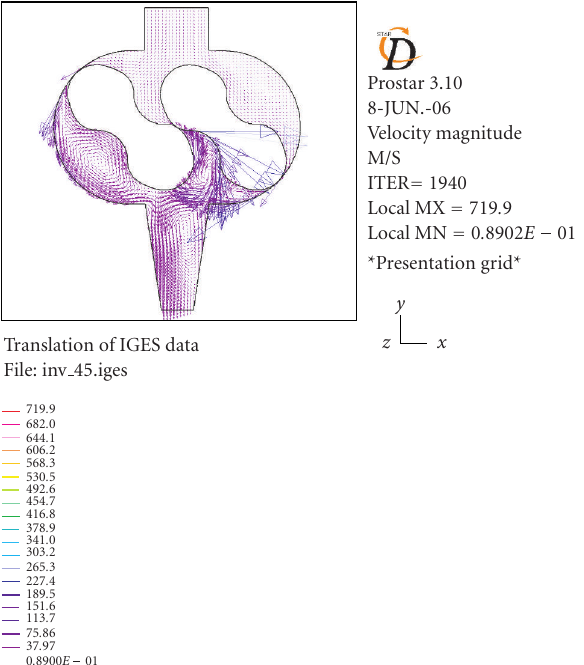
Figure 12: Velocity vector plots for entire machine.